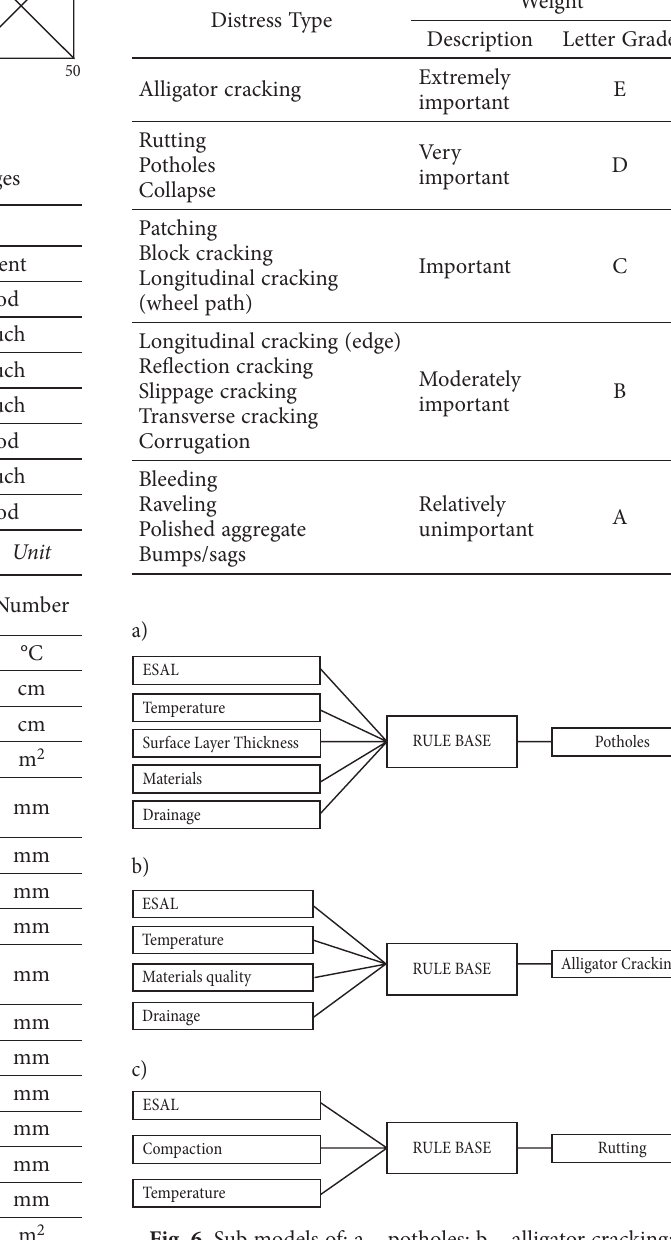
Fig. 6. Sub models of: a – potholes; b – alligator cracking; c – rutting